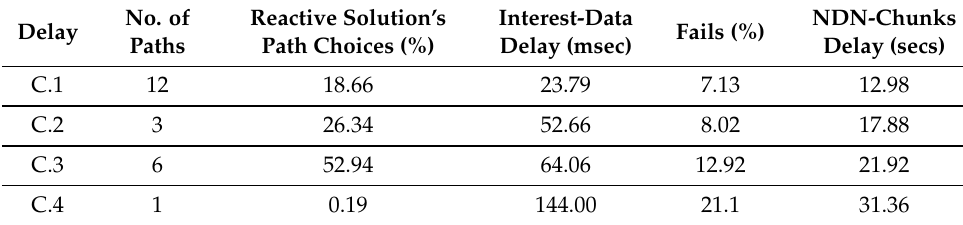
Table 9. Delay clusters average performance.